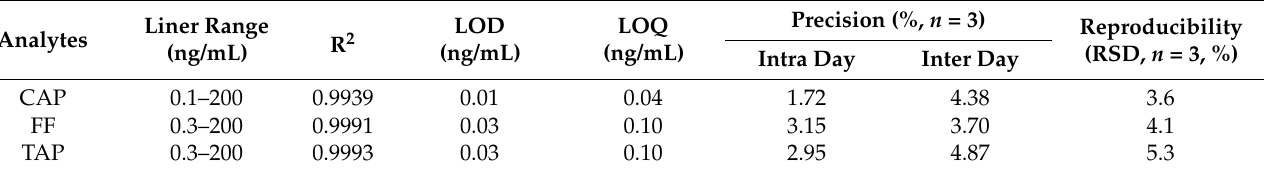
Table 1. Analytical data for 3D COP-SPE method.